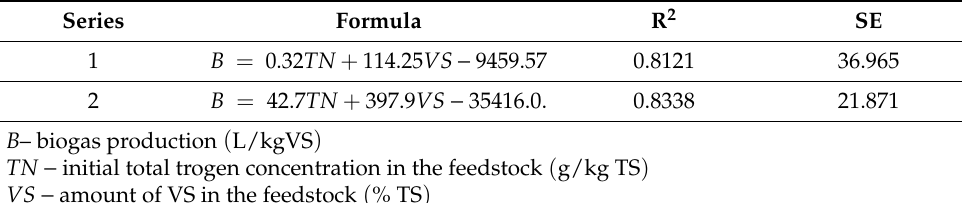
Table 7. Regression equations for the estimation of biogas production (B) with determination coefficient (R 2 ) and standard error (SE).